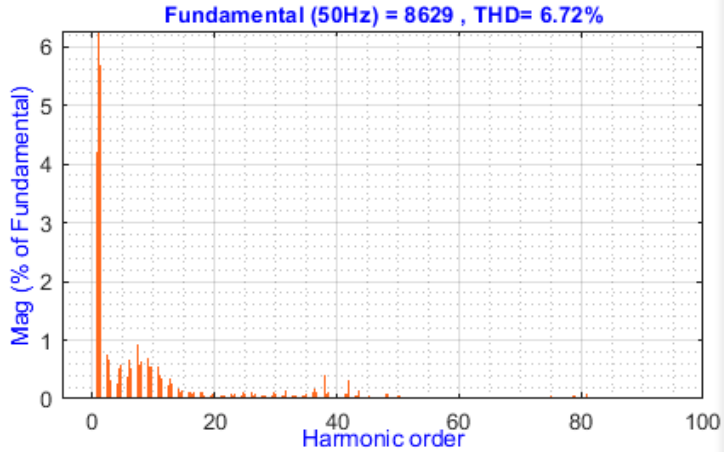
Figure 13. Total and individual harmonics levels of the output voltage at the point of common coupling (PCC).